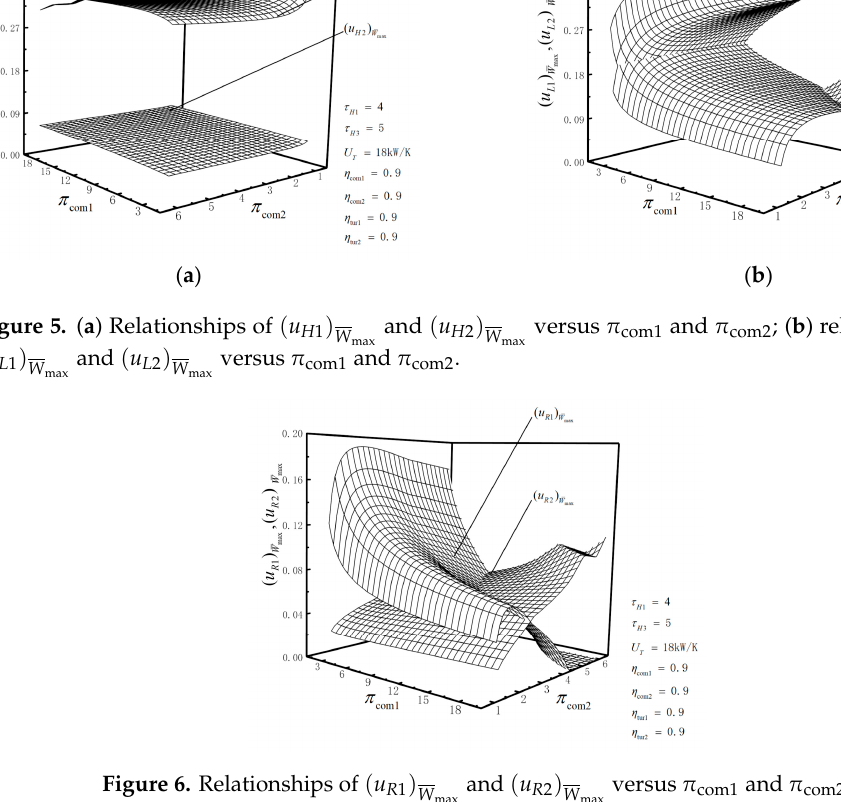
Figure 6. Relationships of